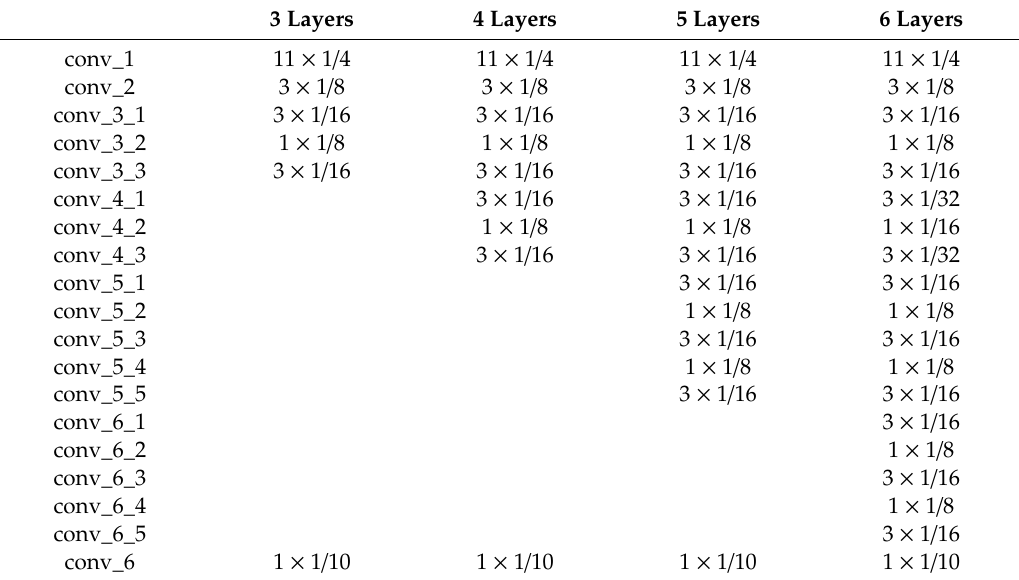
Table 9. Description of network structures with various